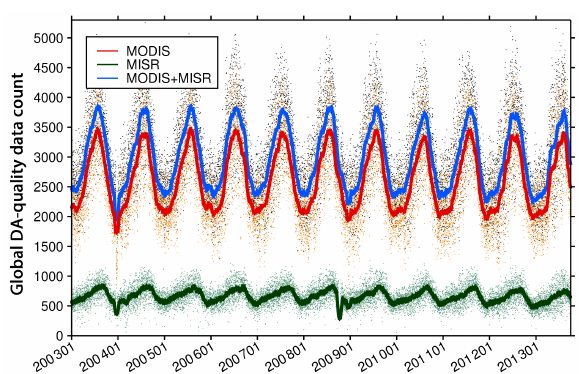
Figure 3. The time series of 6-hourly data count of the global 1 × 1 grid MODIS (Terra + Aqua) (red), MISR (green), and fused MODIS–MISR data assimilation quality AOT (blue). Dots show 6- hourly data counts, and the solid lines represent the 30-day-running average. The seasonal variation of the data volume is mainly related to the fact that more AOT data are discarded for the Southern Hemi- sphere high latitudes than the Northern Hemisphere high latitudes considering cloud contamination (see text for